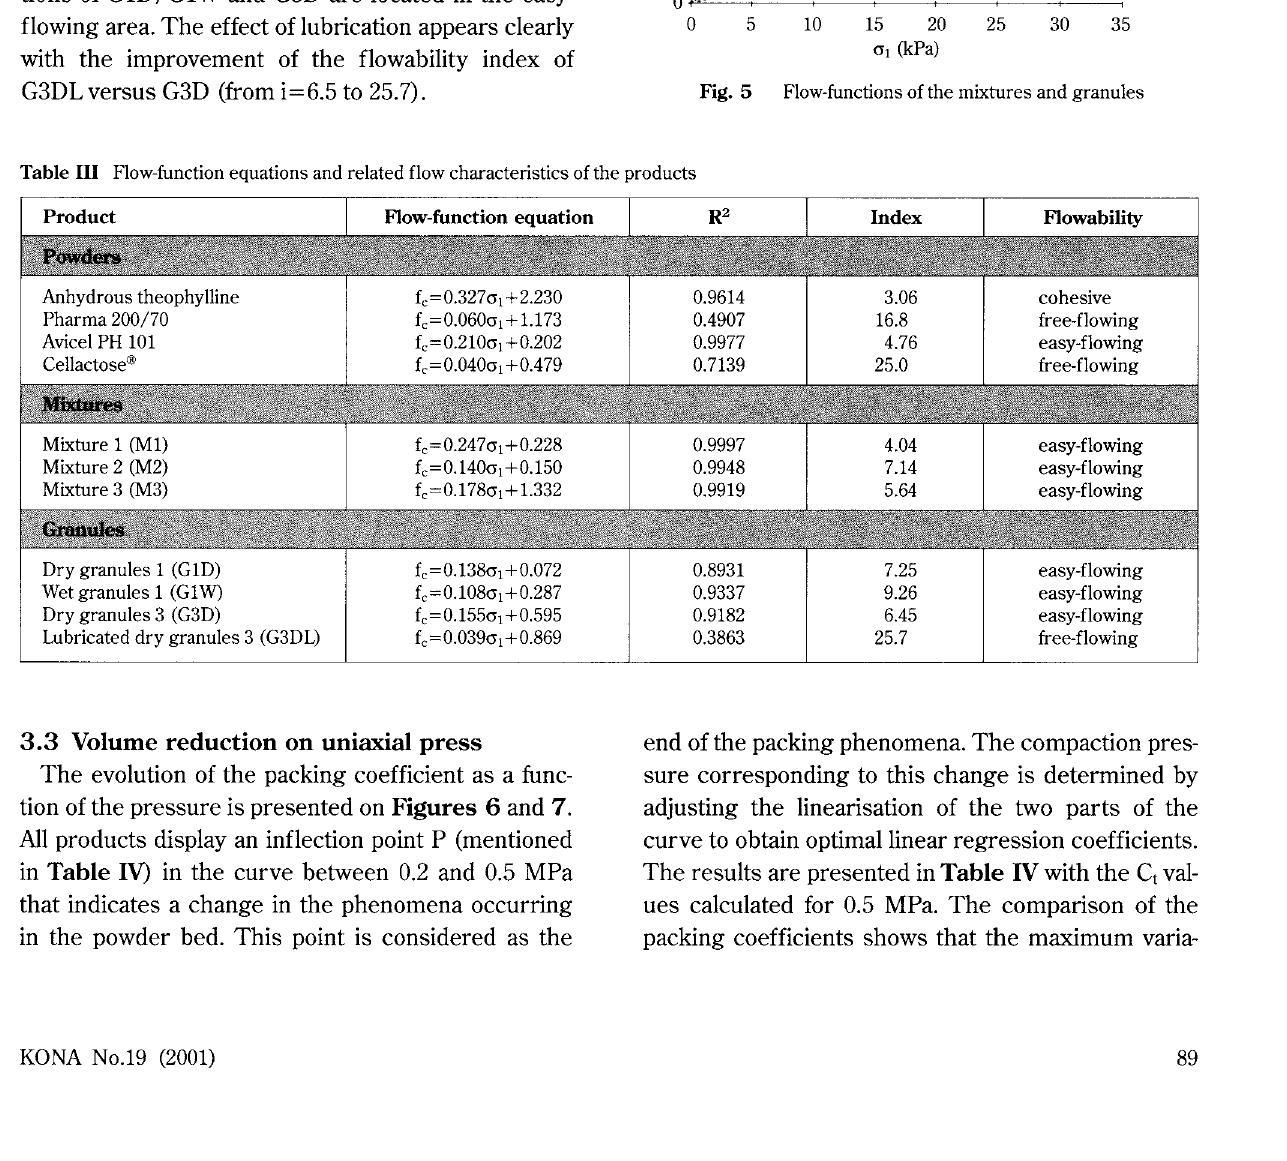
Fig. 5 Flow-functions of the mixtures and granules